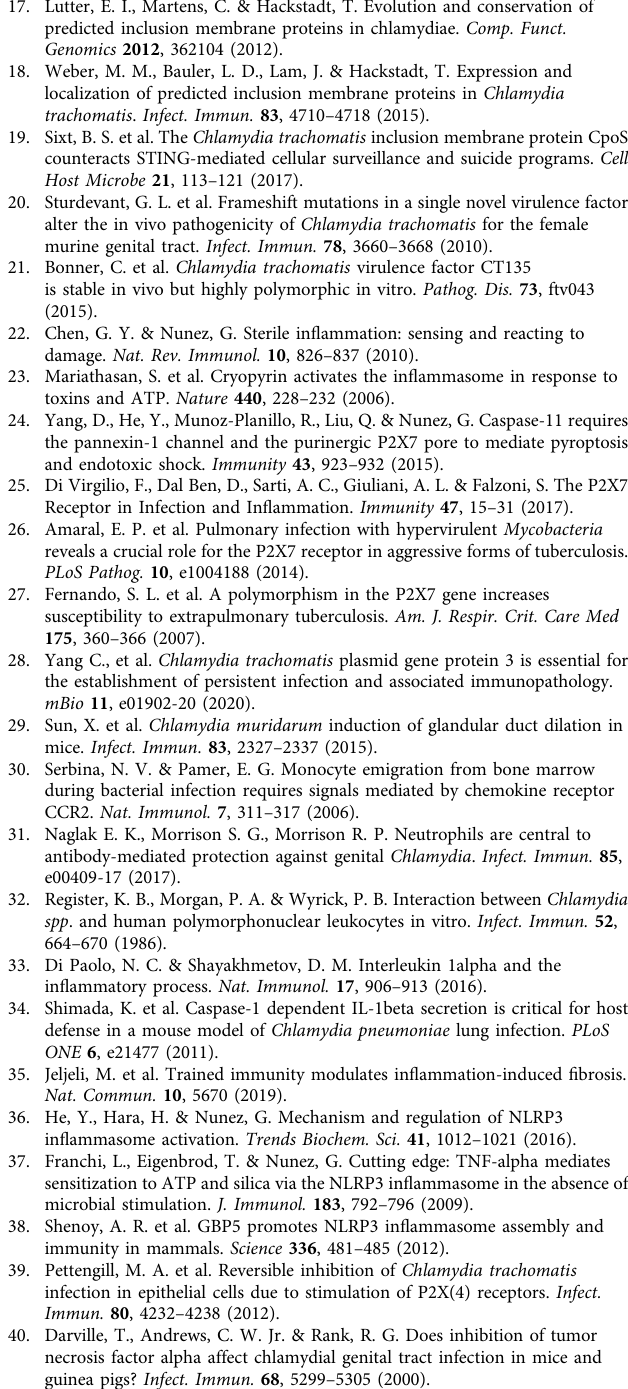
Fig. 7 A model of sterile in fl ammation generated by chlamydial infection of uterine epithelium. a NLRP3 in fl ammasome activation through ATP-P2X7 signaling pathway in phagocytic cells. b ATP released from chlamydiae infected oviduct epithelial cells (Fig. 6a) and luminal neutrophils function (i) directly through penetrating the lamina propria facilitated by matrix metallopeptidase 9 (MMP9) degradation of extracellular matrix molecules that has been shown to amplify the in fl ammatory response to chlamydial infection 56 , or (ii) by paracrine/autocrine via P2R cascading purinergic signaling and exacerbation of the macrophage in fl ammatory response 57 . Because immunopathology occurs independently of the IL-1R and various PAMPs, we